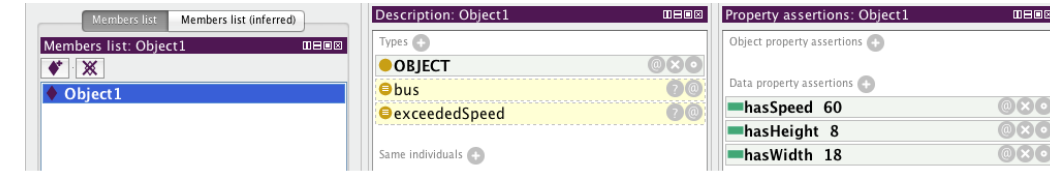
Figure 6. Classified